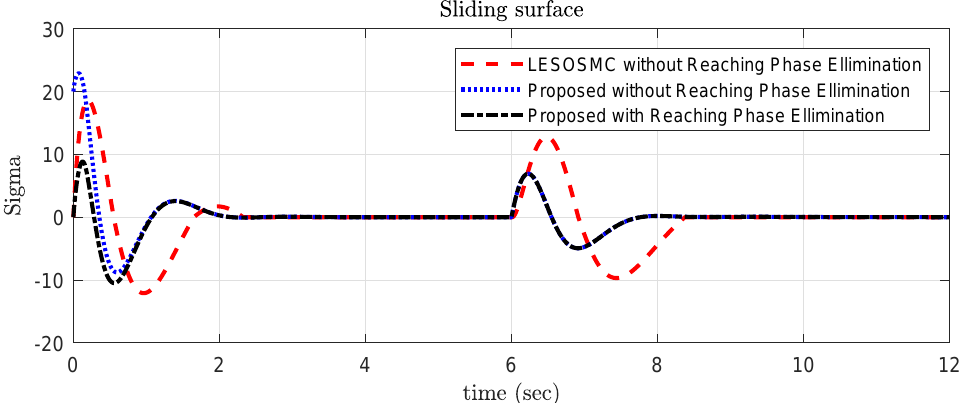
Figure 3. Sliding surface response for Example